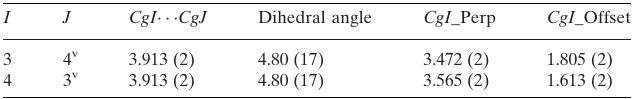
Table 3 (cid:3) – (cid:3) interactions (A˚ , (cid:4) ). Cg 3 and Cg 4 are the centroids of the C5–C8/C13/C14 and C18–C23 rings, respectively. CgI (cid:2)(cid:2)(cid:2) CgJ is the distance between ring centroids. The dihedral angle is that between the planes of the rings I and J. CgI _Perp is the perpendicular distance of CgI from ring J. CgI _Offset is the distance between CgI and perpendicular projection of CgJ on ring I